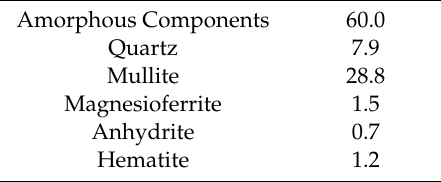
Figure 1. X-ray di ff ractograms of used cement and fly ash. Figure 1. X-ray diffractograms of used cement and fly ash. Table 2. Mineralogical composition of used fly